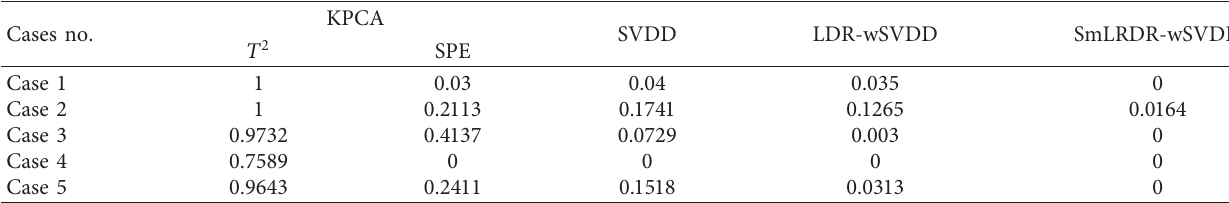
Table 8: MAR under five cases on